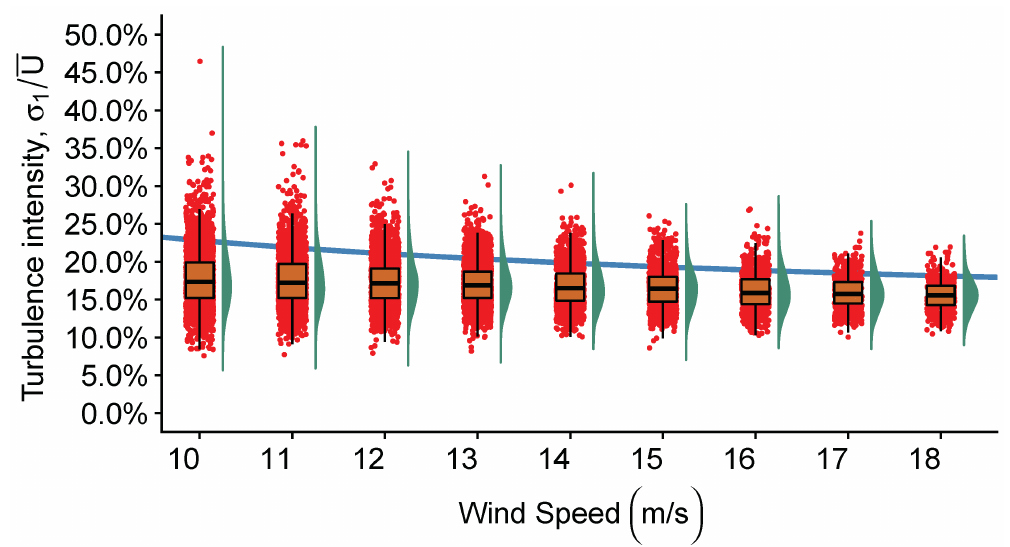
Figure 11. Box plot with NTM using I 15 = 0.18 (blue line), raw data (red dots) and the overlaid probability distribution, at a height of 40 m.